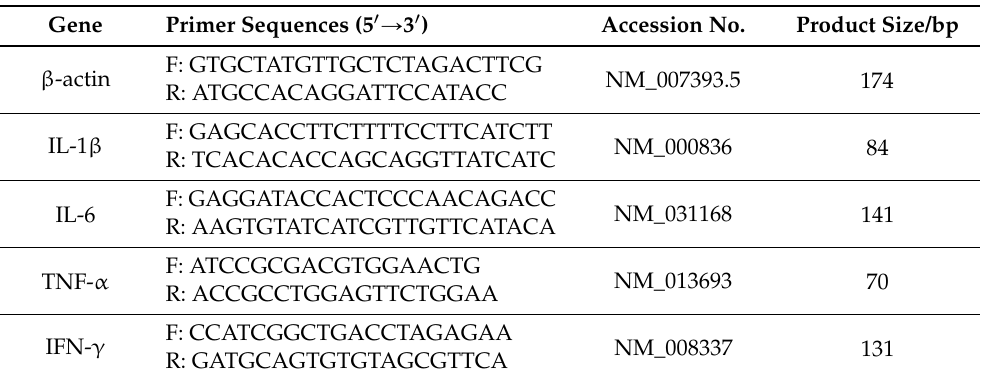
Table 3. Primers for real-time PCR